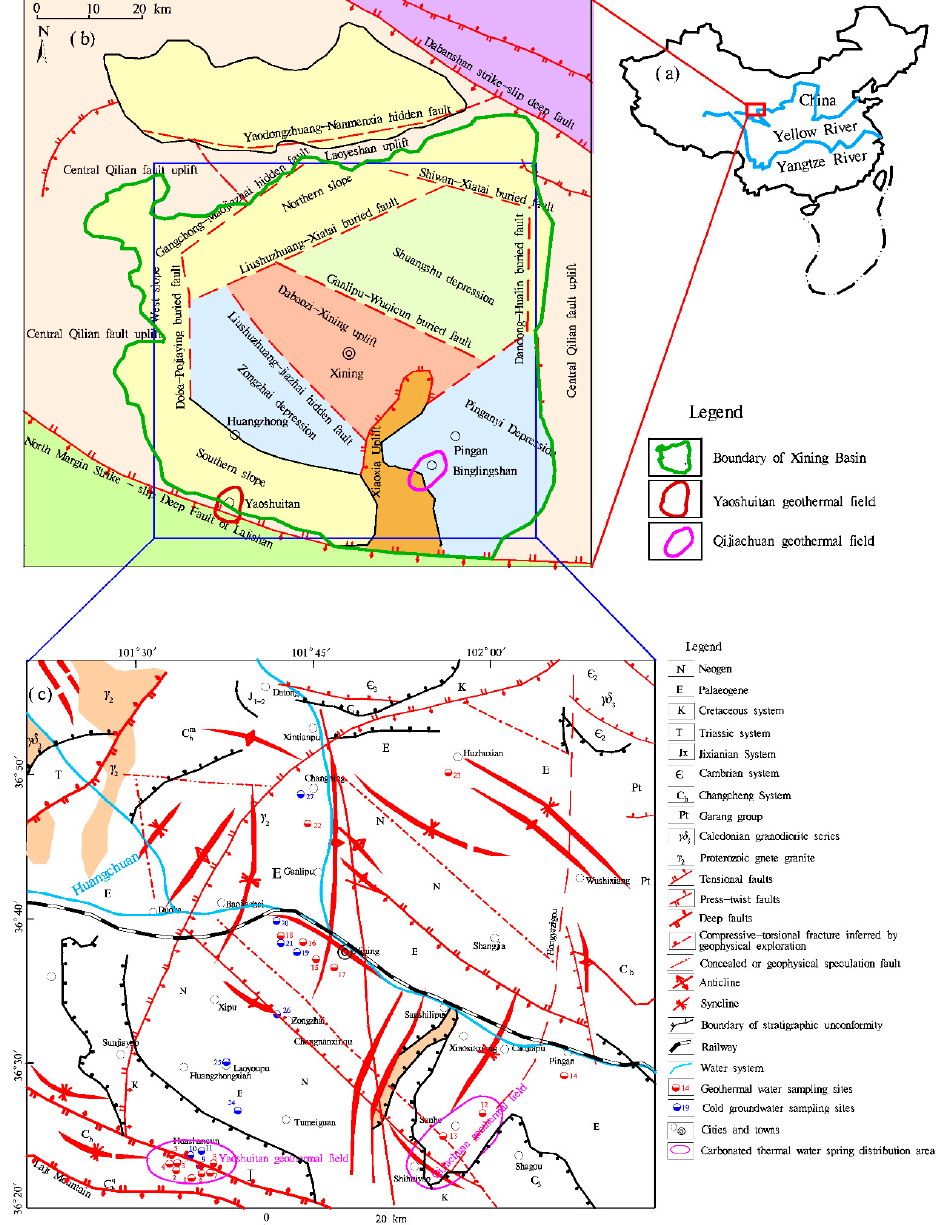
Figure 1. Sketch of geological structure and sampling points and fault location in Xining Basin (slightly modified from reference [27]).